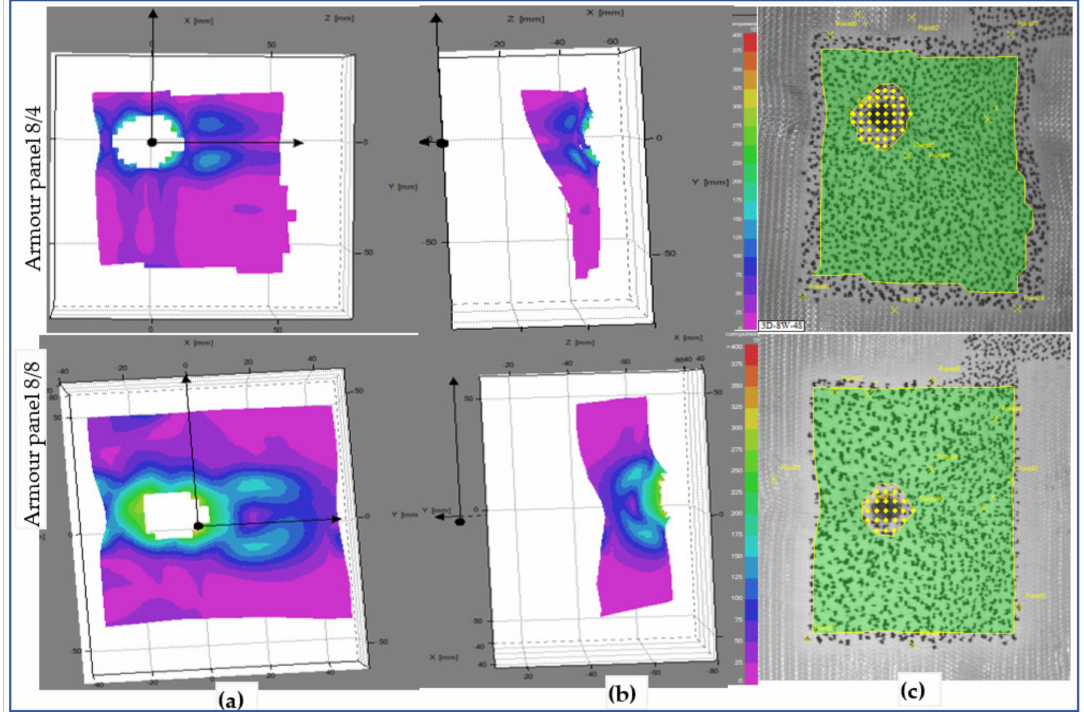
Figure 14. Surface displacement of frontal armour panel at impact times of 0.18 ms ( a ), ( b ), 3D frontal and side views of stereoscopic images, respectively, and ( c ) frontal panel images at shot point